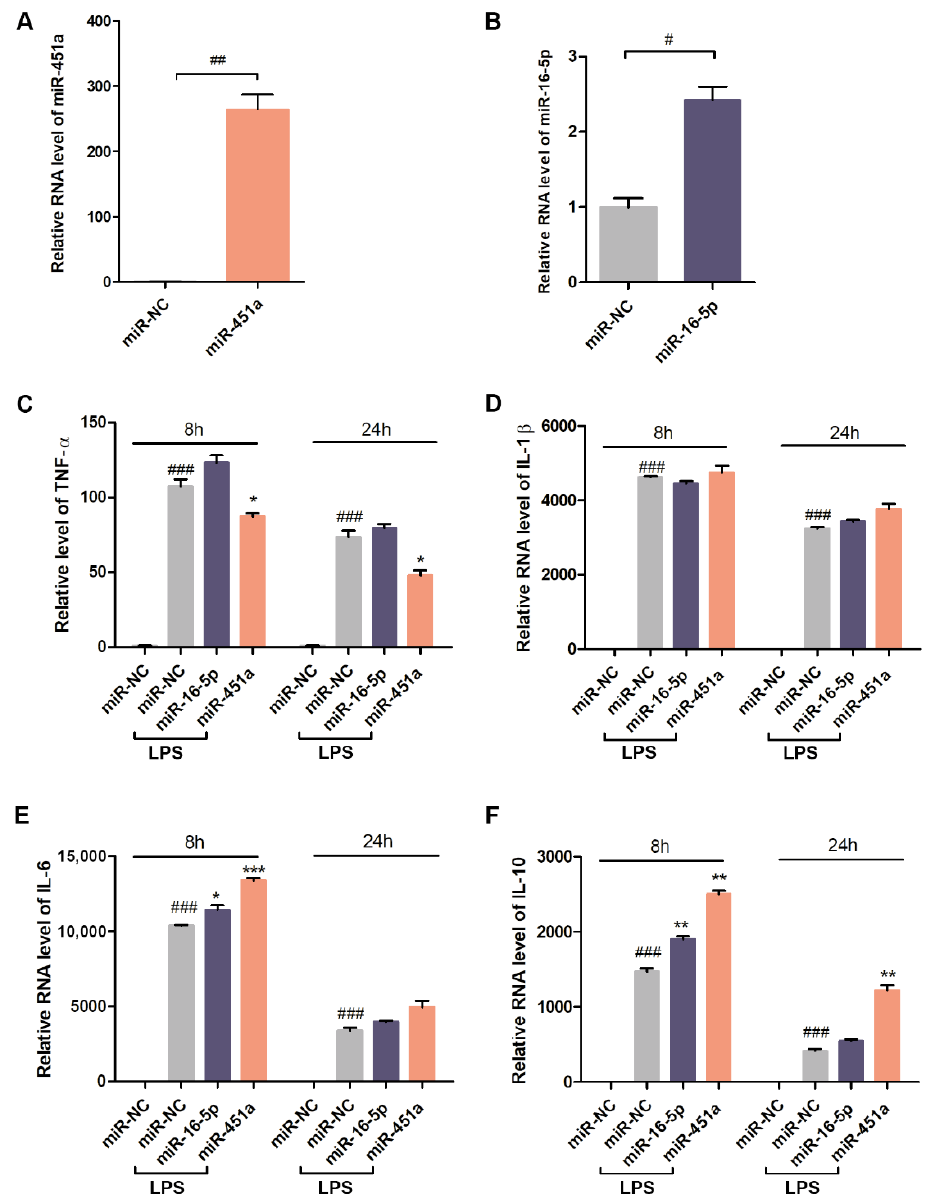
Figure 5. Effects of miR-451a and miR-16-5p synthetic mimics on Raw 264.7 macrophages. ( A , B ) Intracellular levels of miR-451a and miR-16-5p after transfecting cells with miRNA mimics. ( C – F ) RNA expression levels of TNF- α , IL-1 β , IL-6, IL-10 in the presence of miR-451a and miR-16-5p mimics in cells exposed to LPS. Data are presented as mean ± SEM of three replicates. Statistics by ANOVA with Tukey’s multiple comparison post-hoc analysis. # , p < 0.05; ## , p < 0.01; ### , p < 0.001 in comparison to miR negative control (NC) without LPS unless otherwise indicated. *, p < 0.05; **, p < 0.01, ***, p < 0.001 in comparison to miR-NC with